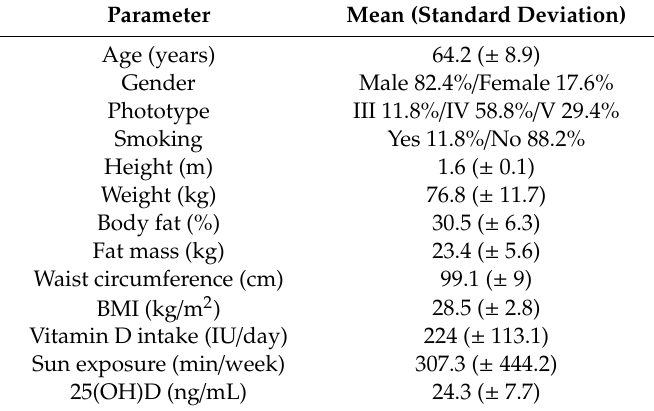
Table 1. Serum 25(OH)D levels, demographic, lifestyle, and anthropometric parameters in patients with heart